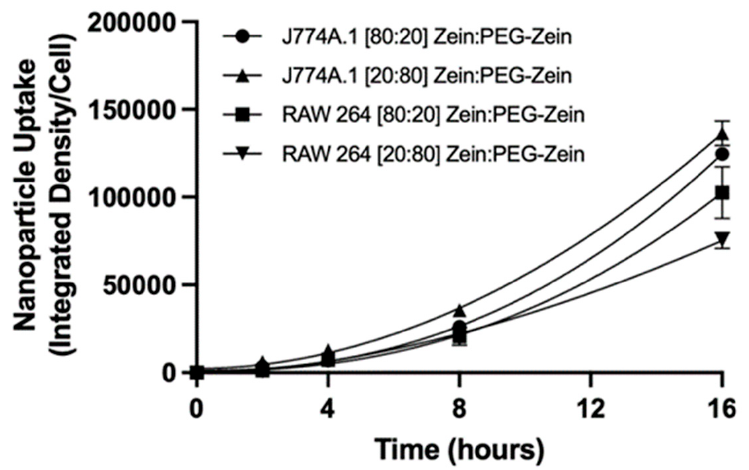
Figure 9. Phagocytic cell Zein nanoparticle (NP) uptake. RAW 264 and J774A.1 uptake over a 16 h period at 37 °C dosed with 1000 µ g/mL of [20:80] or [80:20] Zein:PEG-Zein NPs coupled to CF-647.